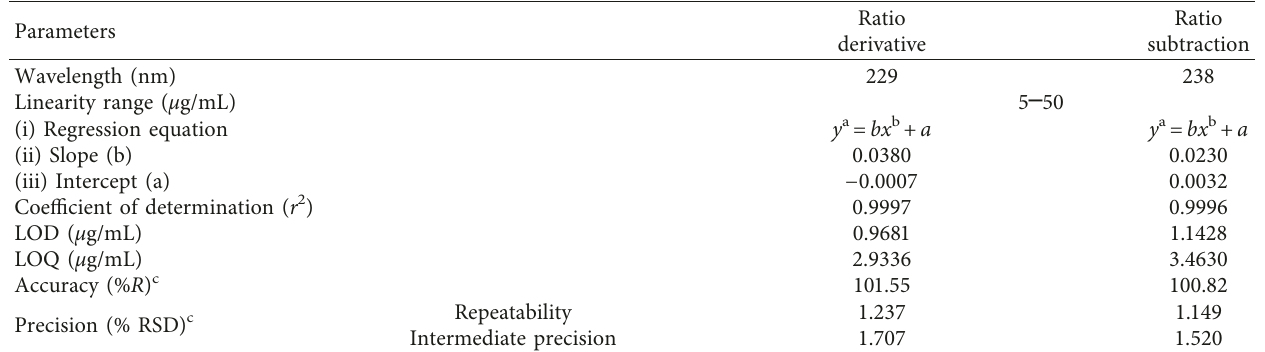
Table 1: Regression and validation of data for determination of aclidinium by the proposed ratio derivative and ratio subtraction methods. Parameters